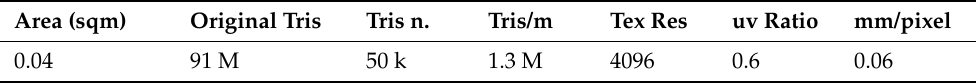
Figure 16. Full Chrysippus 3D model workflow. Table 1. Metrics of the model of Chrysippus: area expressed in sqm, number of triangles of the original and reduced models as well as the geometrical resolution (number of tris per meter) and the texture resolution (considering that the uv mapping uses actually just 60% of the full atlas